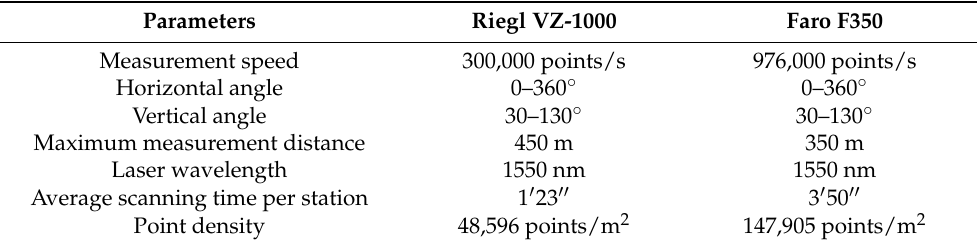
Figure 2. Distribution of scan stations: ( a ) the Saihanba forest area; ( b ) the Laohugou forest area. Table 1. Instrument parameters setting.